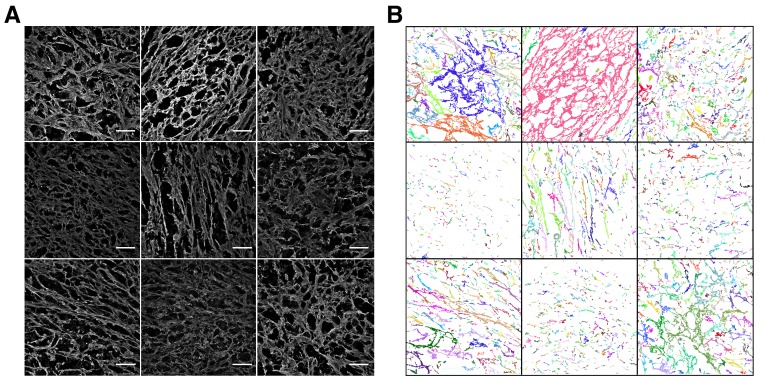
Fields of view from fibronectin fiber analysis.These are the same fields of views of immunostated primary tumors for fibronectin displayed in Figure 3B. (A) Monochrome display presented in grey levels for fibronectin only (microscope emission peak wavelength: 614 nm). Scale bar: 50 µm. (B) Display of the corresponding segmented objects obtained with the described workflow, the angles of which were measured.